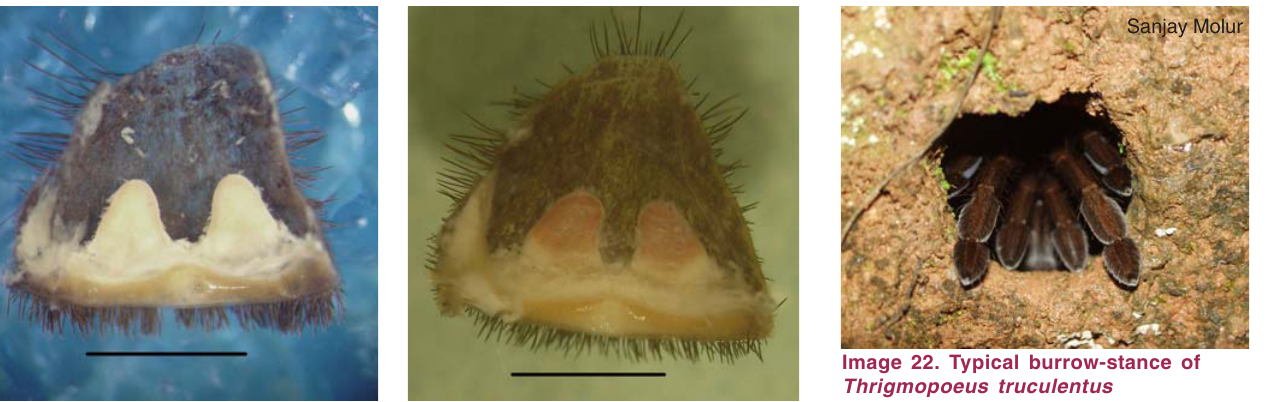
Image 20. Spermetheca of WILD-137. Scale 1.0mm